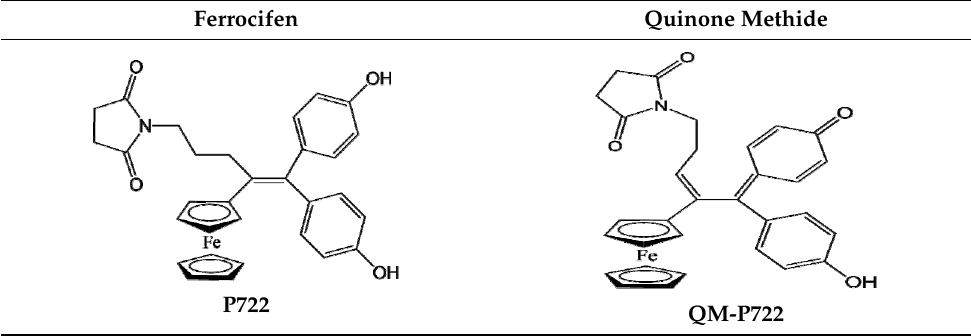
Table 2. IC 50 values in µM on some cancer cell lines (breast, glioblastoma, melanoma and ovarian) of P5 and P15 ferrocif- ens.